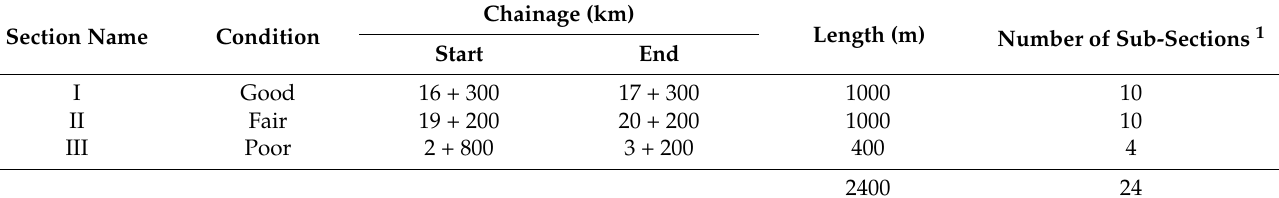
Table 8. Characteristics of examined